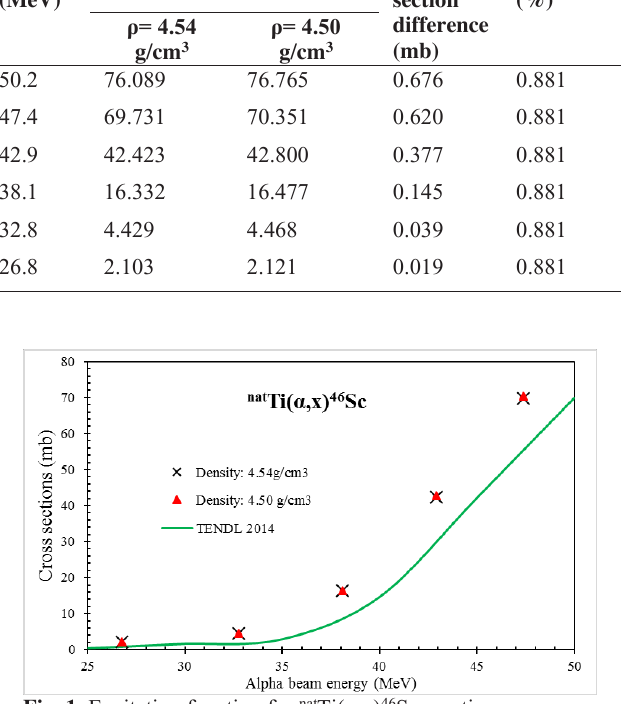
Fig. 1. Excitation function for nat Ti(α,x) 46 Sc reaction